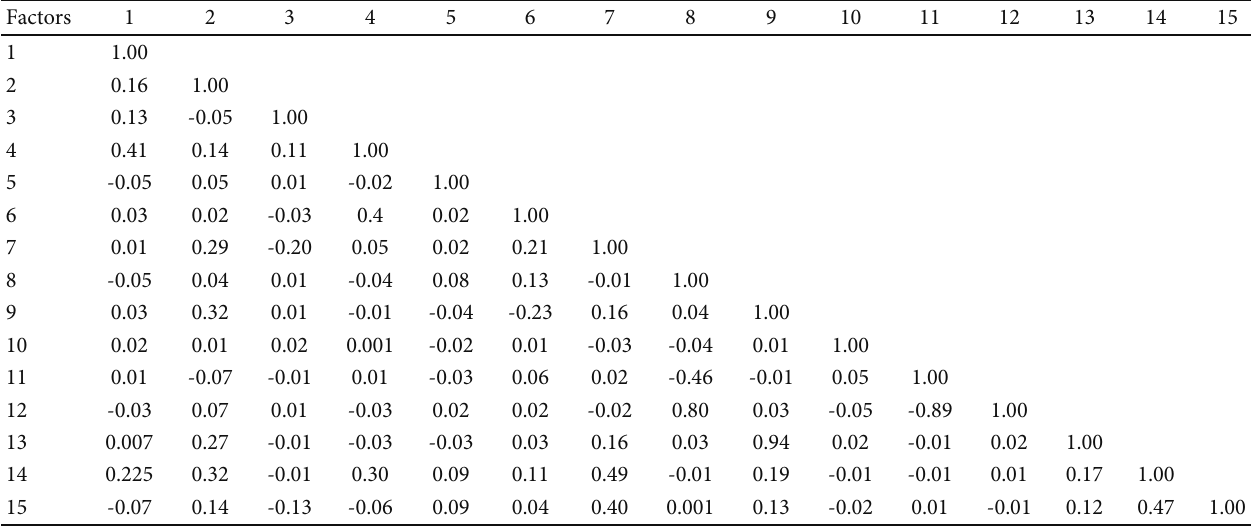
Table 5: Correlation matrix of evaluation factors based on Pearson coe ffi cient method.